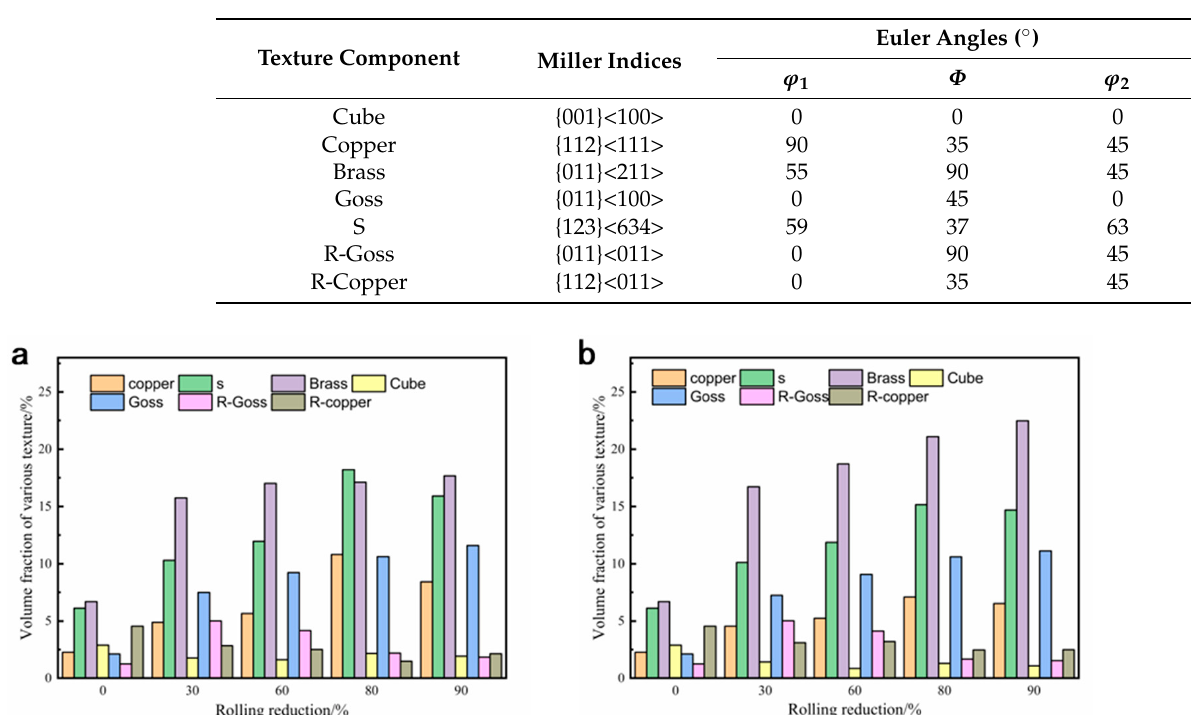
Table 4. Important rolling texture components for FCC alloy [26].